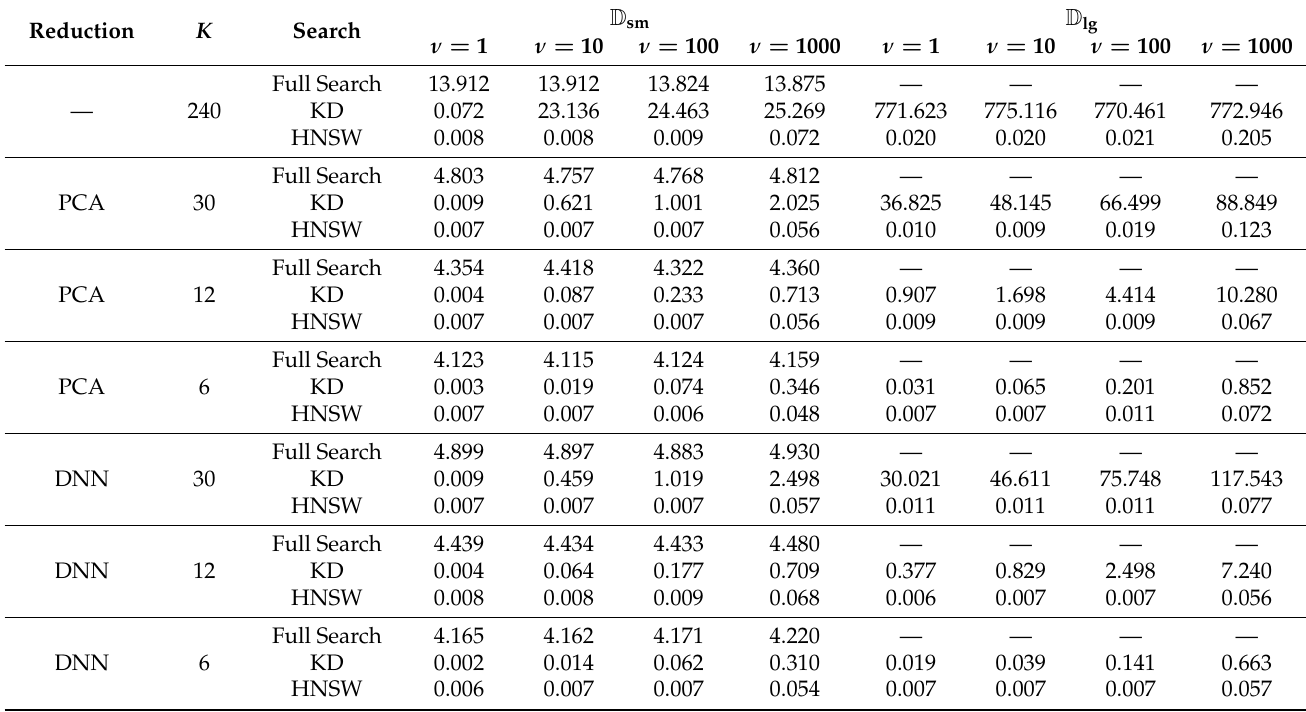
Table 6. Search runtimes (in ms) using a single query for various dimensions K and search strategies. Reduction